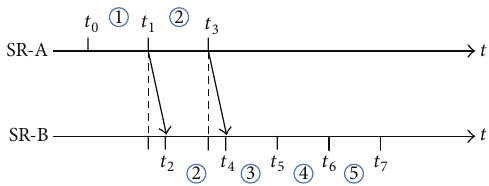
Figure 11: Main steps of virtual router migration between SR-A and